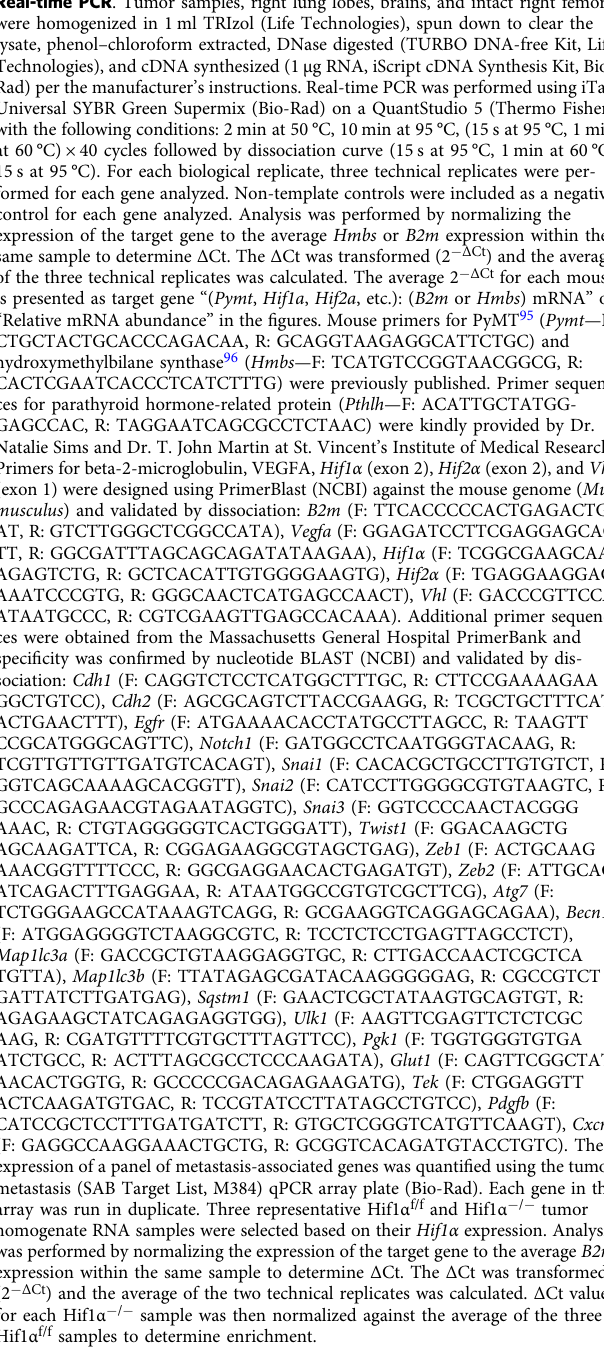
group and error bars represent s.e.m. n = 20 Vhl f/f PyMT + mice, n = 18 Vhl − / − PyMT + mice, n = 19 Hif1 α f/f PyMT + mice, n = 21 Hif1 α − / − PyMT +